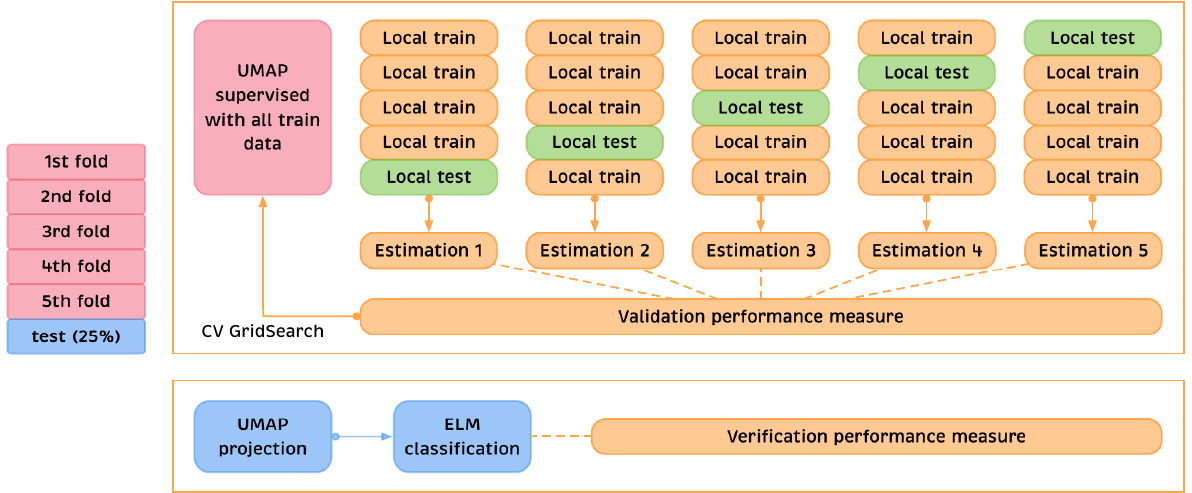
Figure 2. Model validation/verification using 75% of the data in the 5-fold CV used to tune the hyperparameters and 25% of the data for the final